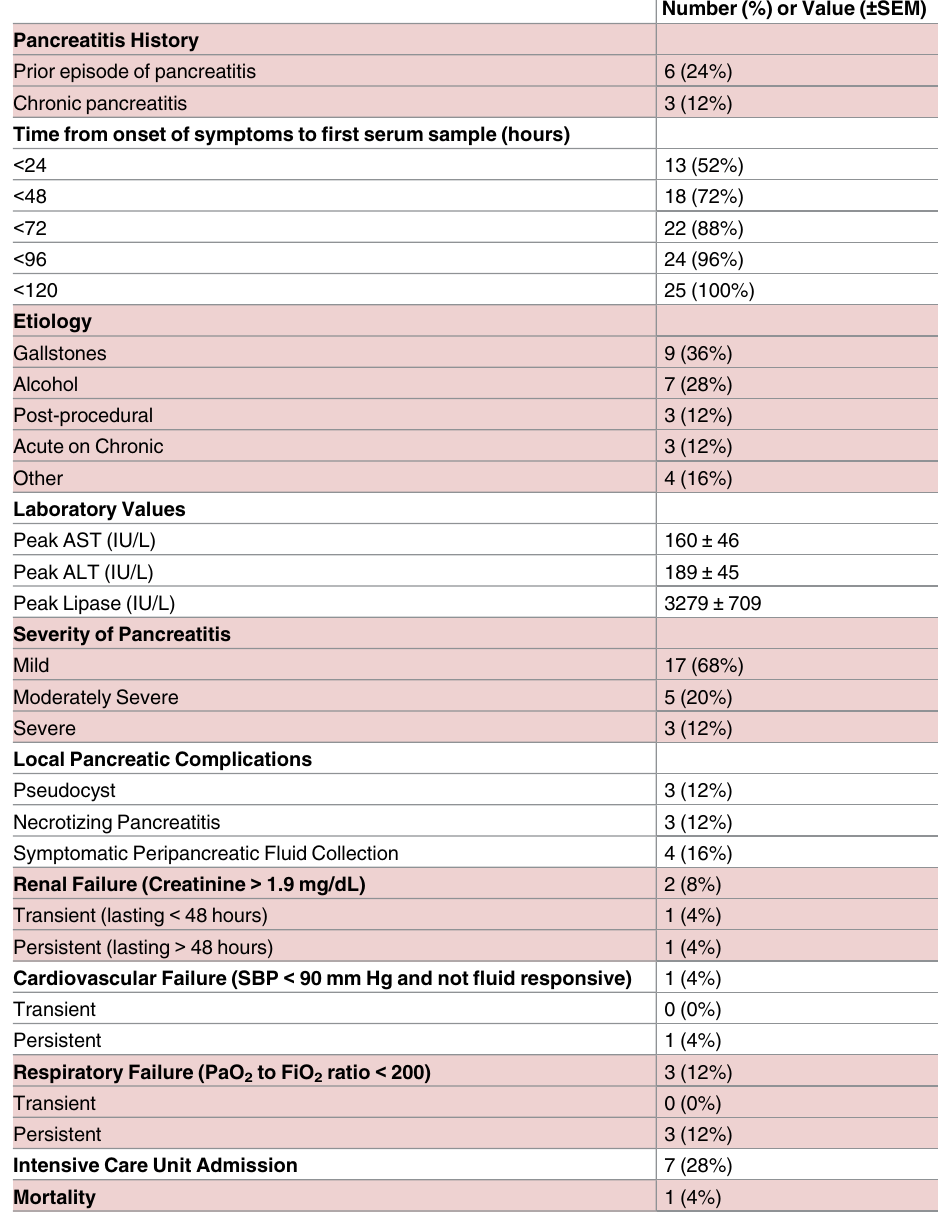
Table 1. Pancreatitis Characteristics and